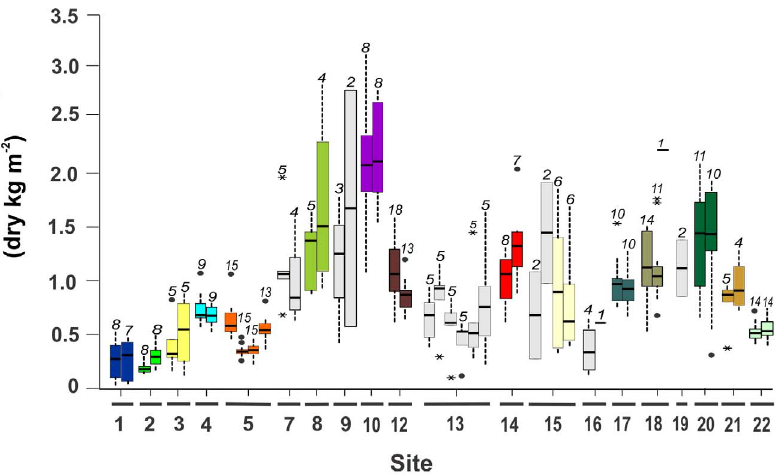
Figure 2. Annual leaf productivity of Thalassiatestudinum per sampling station. The stations are grouped per site (underlined, 1–6 stations per site), and stations only sampled during one season are excluded. The boxes and vertical bars represent inter-annual variation. The horizontal lines correspond with the median values, 50% of the cases are within the box limits and the vertical bars indicate the smallest or largest values that are not outliers, N represent values more than 1.5 box lengths from lower/upper box limit, and * represent values more than 3 box-lengths from lower/upper box limit. The digits above the bars indicate N (the number of sampling years). Grey bars represent stations that were not included in the long-term analysis.